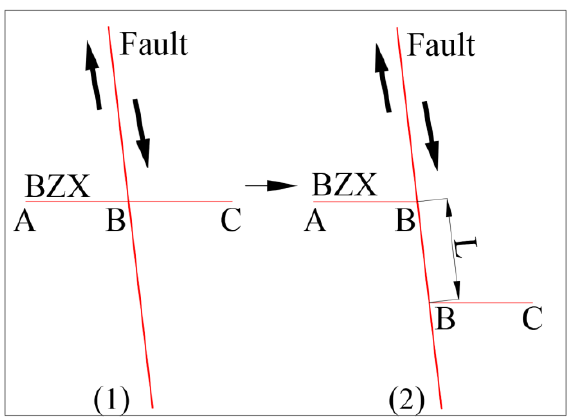
Figure 5. Schematic diagram of the mark line observation method.